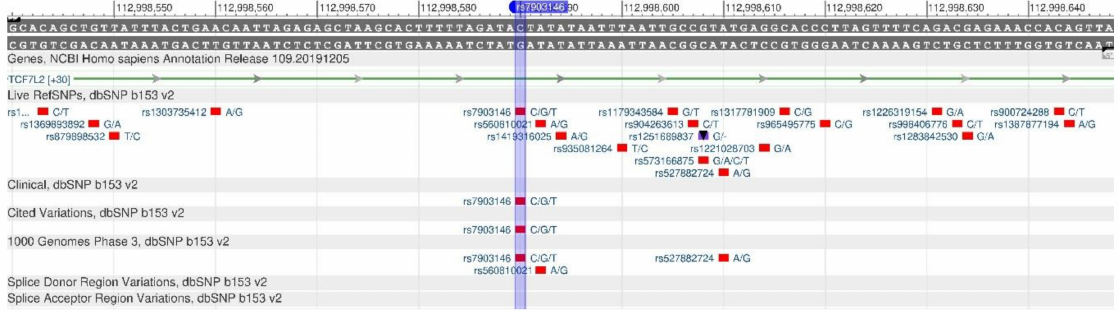
Figure 4. The TCF7L2 gene region (located on the long (q) arm of chromosome 10) containing the oligonucleotide polymorphism